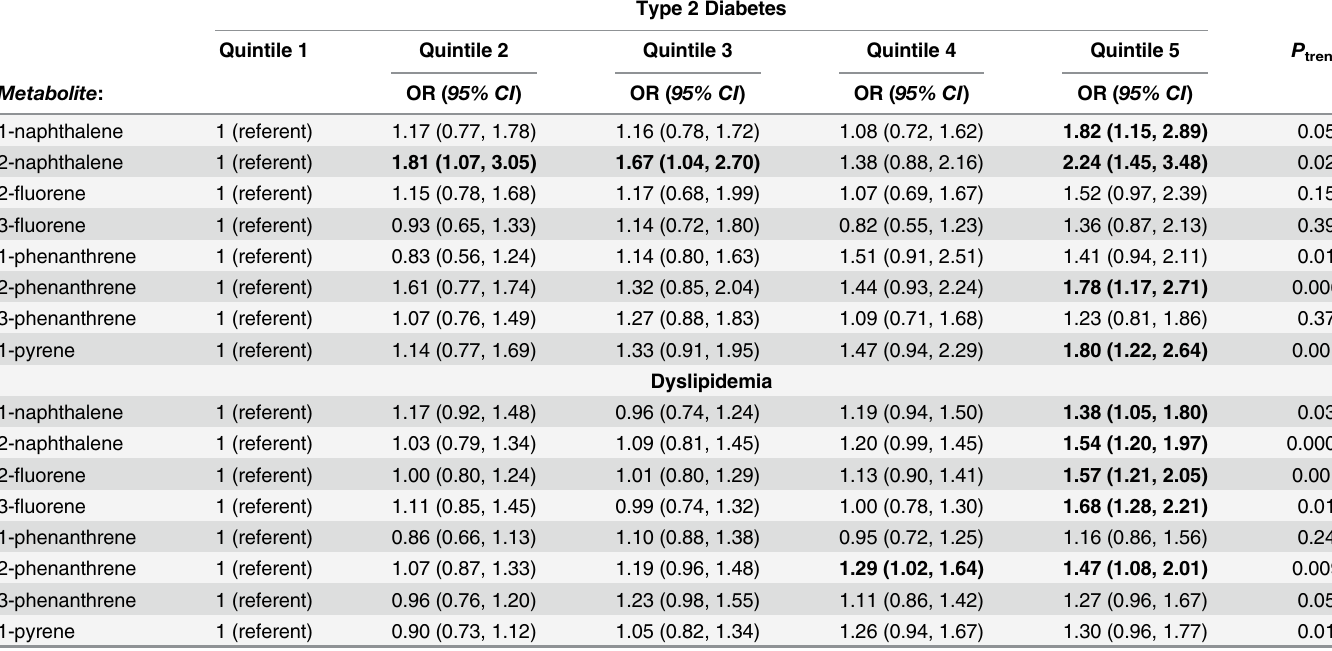
Table 4. Weighted and adjusted odds ratios for quintiles of PAH, and type 2 diabetes and